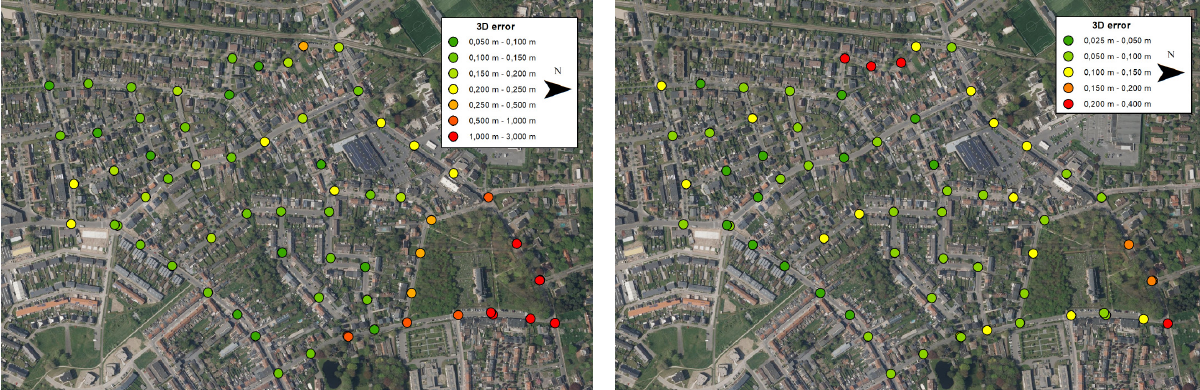
Figure 6. 3D errors of GCP in residential dataset for the low-end system (left) and high-end system (right).